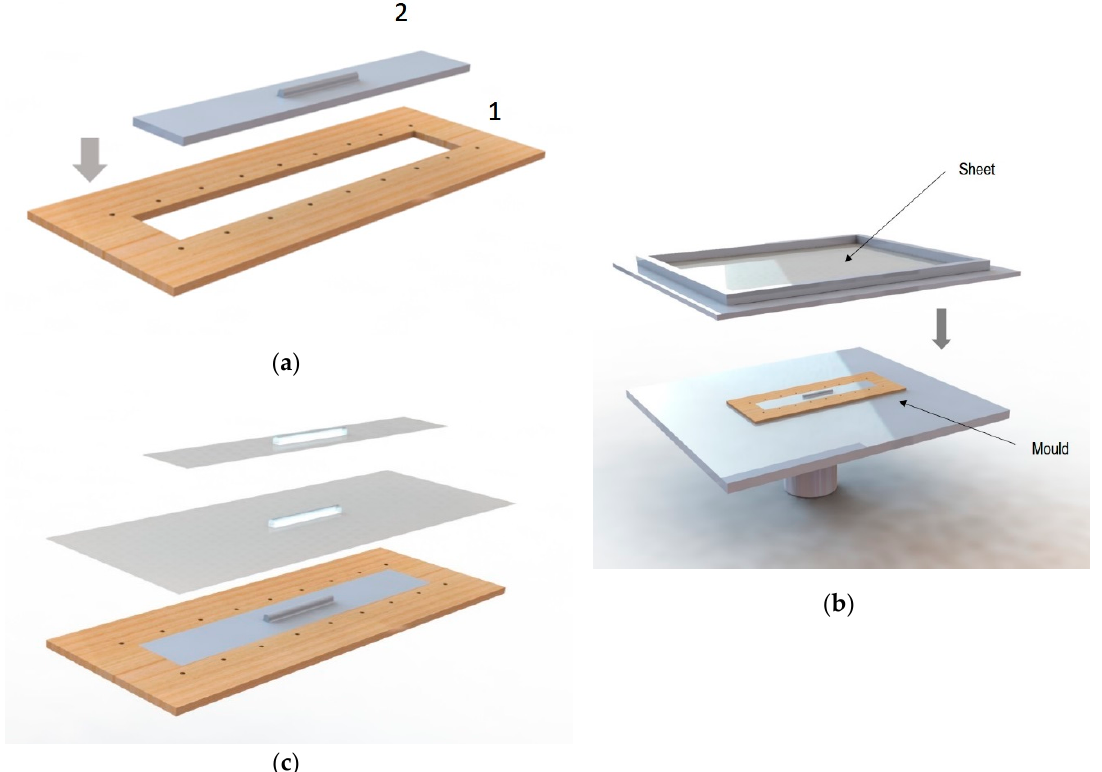
Figure 2. Thermoforming of specimens for tensile tests: ( a ) Hybrid mould; ( b ) Thermoforming of the sheet with hybrid mould to obtain the thermoformed sheet specimen; ( c ) Procedure for obtaining the thermoformed specimen.